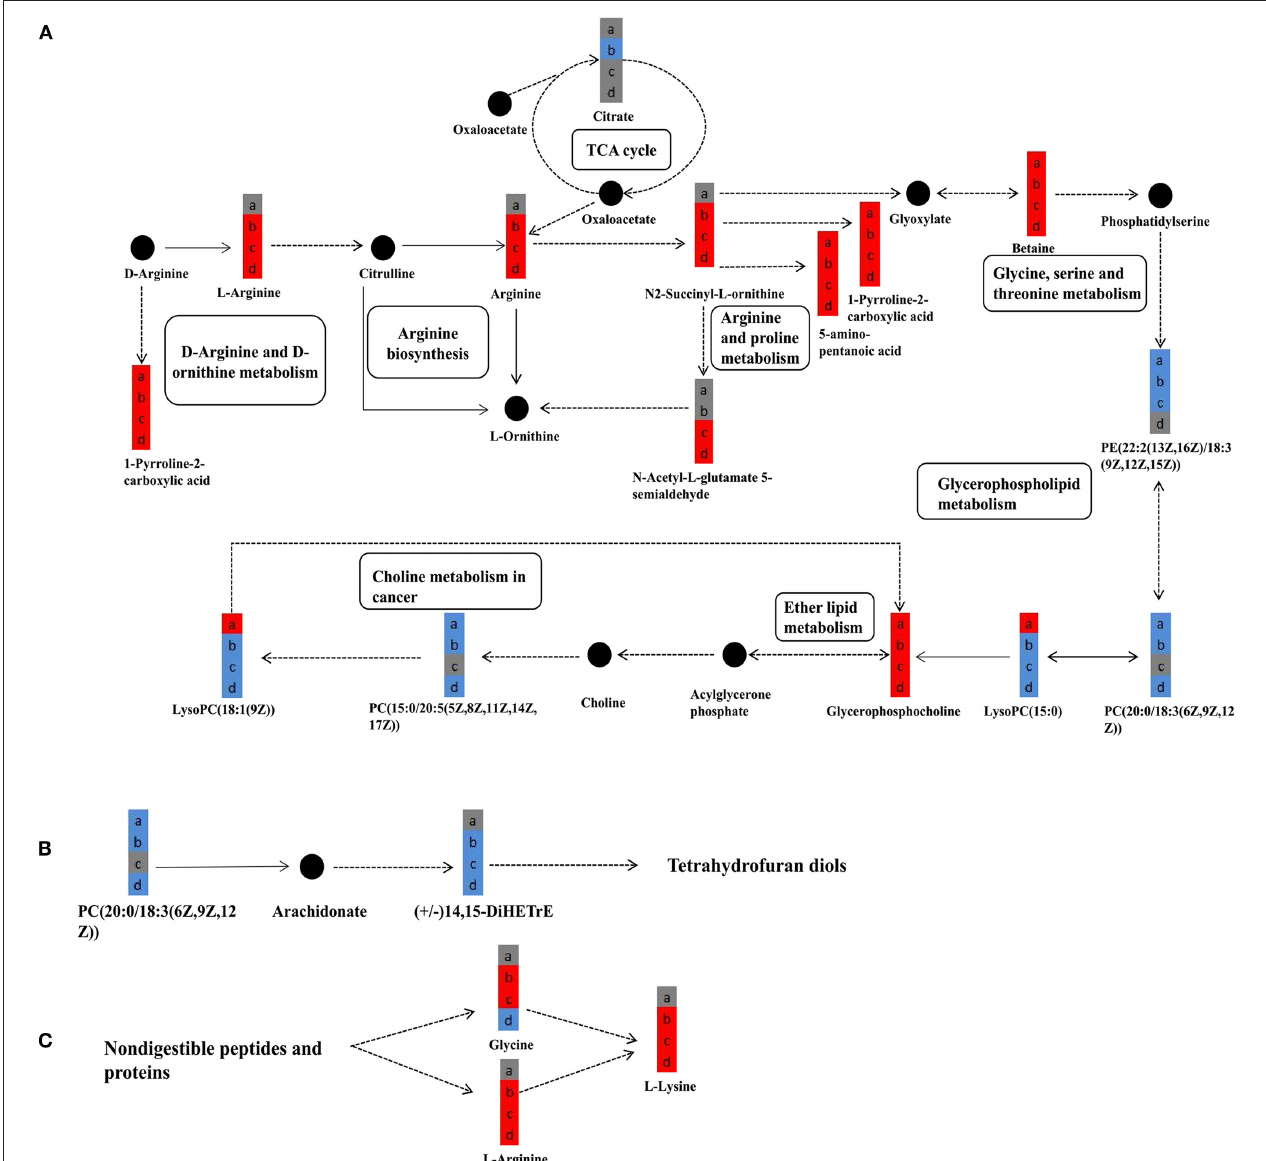
FIGURE 9 | Significantly different metabolites in metabolic pathways in different combinations. (A) The major metabolic pathways of significantly different metabolites. (B) Tetrahydrofurandiols pathway. (C) Lysine-related pathway. a, b, c, and d represent PBA0 vs. control, PBA.1 vs. control, PBA1 vs. control, and PBA5 vs. control, respectively. Solid and dashed lines represent direct and indirect procedure, respectively. Red and blue colors represent upregulation and downregulation, respectively, and gray color represents no significant change. Filled circles with black color represent metabolites in the pathway but undetected in the study.